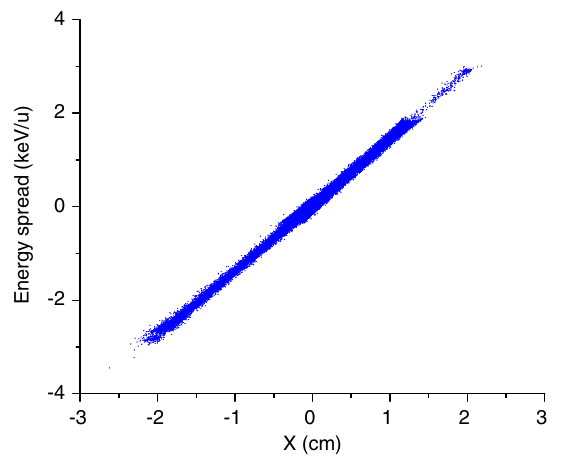
FIG. 16. Simulated beam in the ð x; (cid:1)W Þ phase space at the image plane.